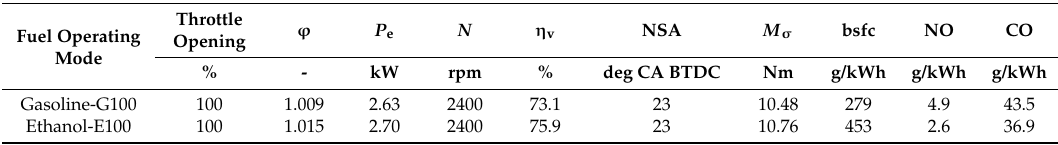
Table 3. Experimental data for the operation of engine “Datsu LT 200”, either with gasoline (G100) or with ethanol (E100), at normal engine operating point